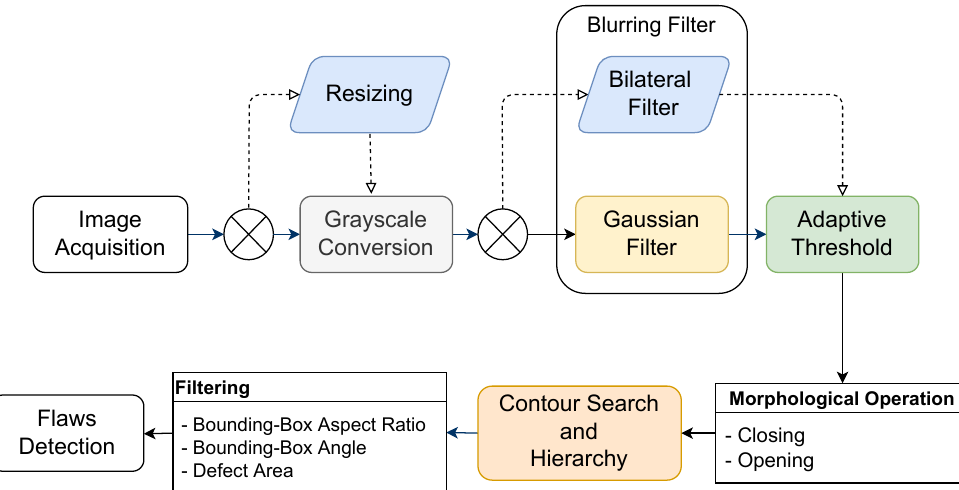
Figure 4. Schematic representation of the workflow of the proposed system to perform pattern analysis in the bridge inspection